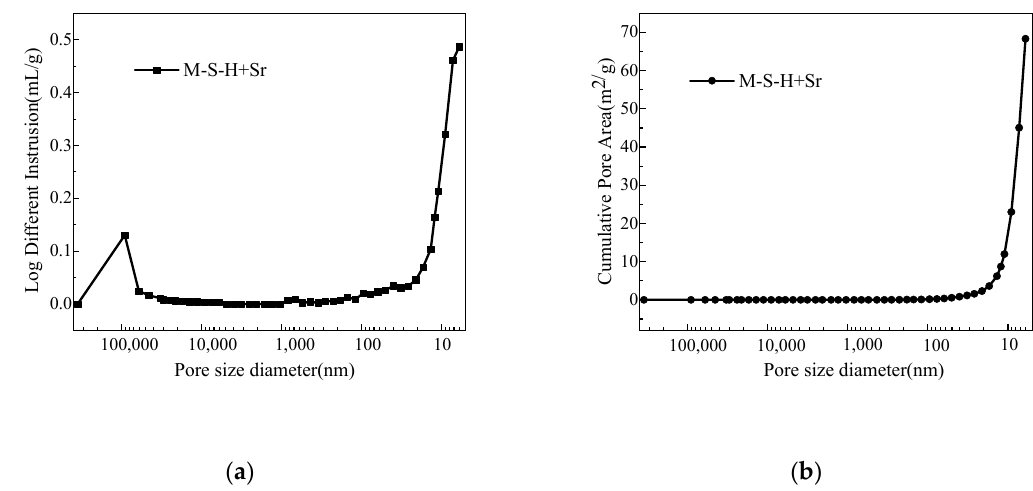
Figure 6. Mercury intrusion porosimetry (MIP) results of the MgO–SiO 2 –H 2 O solidified body (water–cement ratio, 0.65; Sr 2+ content, 1.6 wt.%); ( a ) log different intrusion; ( b ) cumulative pore area. Table 4. Mercury intrusion porosimetry (MIP) results of the MgO–SiO 2 –H 2 O solidified body with 1.6 wt.% Sr 2+ .